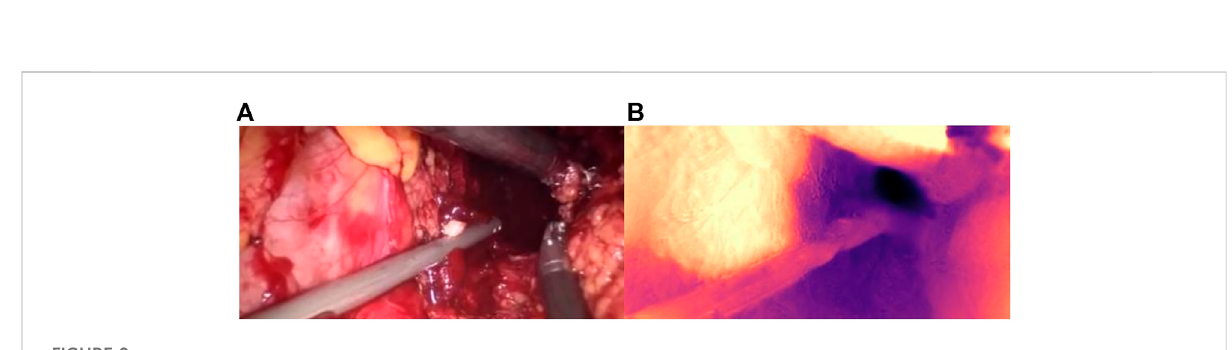
FIGURE 9 Details of the parallax estimation. (A) : Raw endoscope image; (B) proposed model